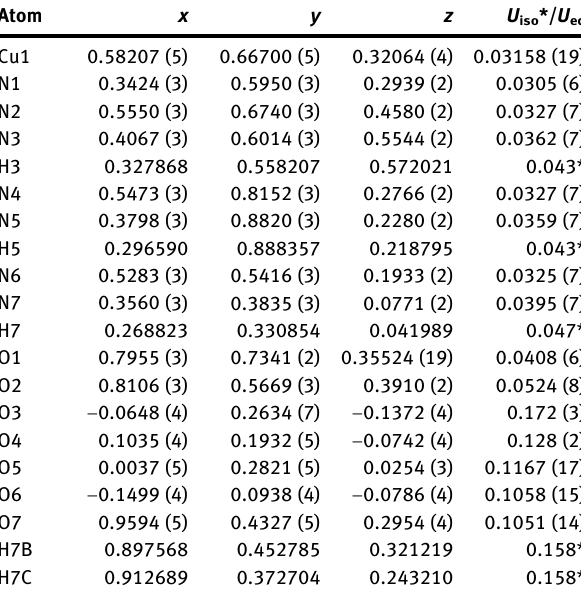
Table  : Fractional atomic coordinates and isotropic or equivalent isotropic displacement parameters (Å 